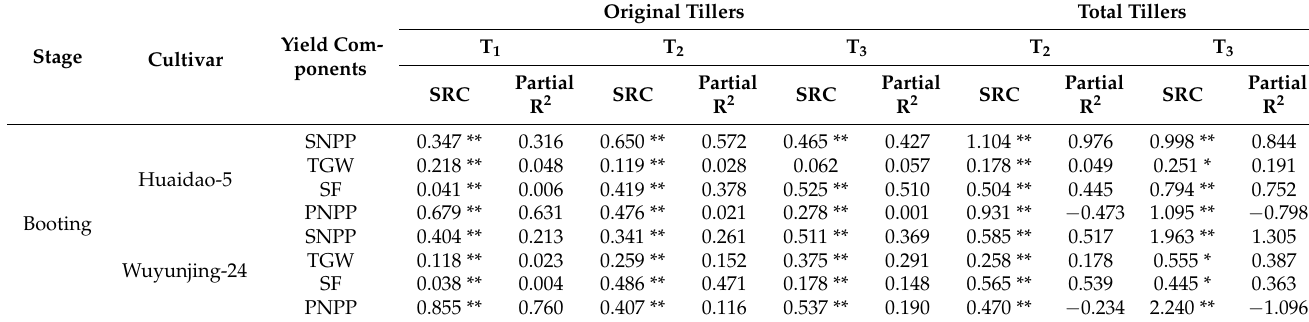
Figure 8. Relationships between the relative grain yield and yield components of Huaidao ‐ 5 and Wuyunjing ‐ 24 and heat degree days (HDD) at booting (BT), flowering (FL), and combined (BT + FL) stages ( a – e ). Blue, black, and red lines are for BT, FL, and BT + FL stages, respectively. Both varieties were used in the graph ( τ was set to 33 °C for BT and 35 °C for FL. Total tillers ( ○ and solid line); original tillers ( △ and dashed line). * p < 0.05, ** p < 0.01. Table 3. Multiple linear regression analysis between grain yield and yield components (includ- ing original and total tillers) of Huaidao-5 and Wuyunjing-24 under different high-temperature levels (T 1 –T 3 ) at booting (BT), flowering (FL), and combined (BT + FL) stages during 2016–2017 growing